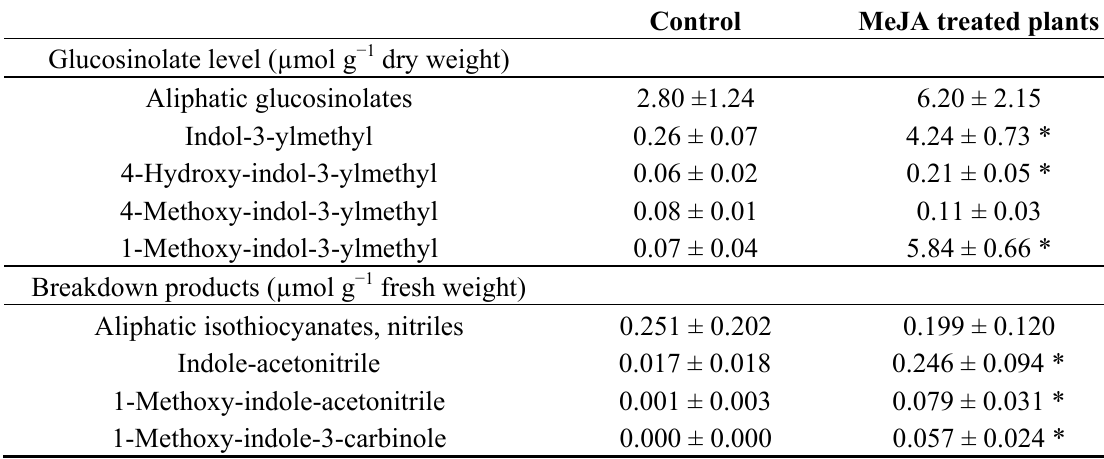
Table 2. Indole glucosinolate levels and corresponding breakdown products. I3M, indol-3-ylmethyl glucosinolate; 4OHI3M, 4-hydroxy-indol-3-ylmethyl glucosinolate; 4MOI3M, 4-methoxy-indol-3-ylmethyl glucosinolate; 1MOI3M, 1-methoxy-indol-3-ylmethyl glucosinolate. MeJA, methyl jasmonate; *, significantly different ( p ≤ 0.05, post-hoc Tukey’s HSD test). Control MeJA treated plants Glucosinolate level (µmol g − 1 dry weight) Aliphatic glucosinolates 2.80 ±1.24 6.20 ± 2.15 Indol-3-ylmethyl 0.26 ± 0.07 4.24 ± 0.73 * 4-Hydroxy-indol-3-ylmethyl 0.06 ± 0.02 0.21 ± 0.05 * 4-Methoxy-indol-3-ylmethyl 0.08 ± 0.01 0.11 ± 0.03 1-Methoxy-indol-3-ylmethyl 0.07 ± 0.04 5.84 ± 0.66 * Breakdown products (µmol g − 1 fresh weight) Aliphatic isothiocyanates, nitriles 0.251 ± 0.202 0.199 ± 0.120 Indole-acetonitrile 0.017 ± 0.018 0.246 ± 0.094 * 1-Methoxy-indole-acetonitrile 0.001 ± 0.003 0.079 ± 0.031 * 1-Methoxy-indole-3-carbinole 0.000 ± 0.000 0.057 ± 0.024